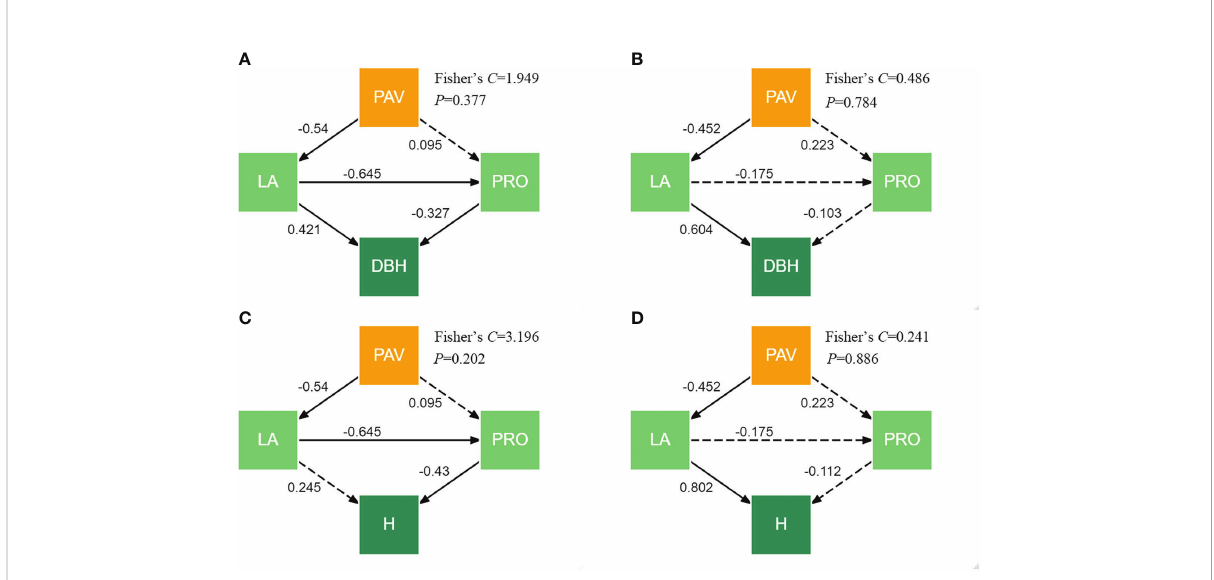
FIGURE 10 Piecewise SEMs showing the direct and indirect effects of the pavement (PAV), leaf area (LA), and proline (PRO) content on the DBH and height (H) for G. biloba (A, C) and P. orientalis (B, D) . Solid arrows represent signi fi cant effects ( P < 0.05), and the dashed arrows indicate nonsigni fi cant effects ( P >